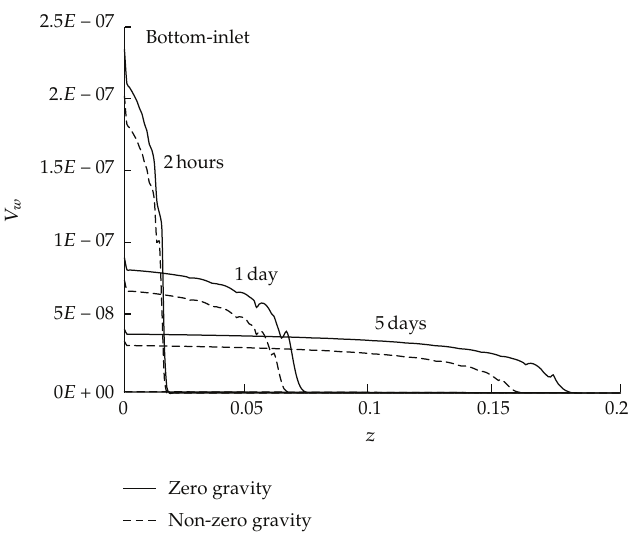
Figure 18: Comparison between considering and neglecting gravity e ff ect on water z -velocity for the bottom-inlet case, at x (cid:8) 0 . 1m.